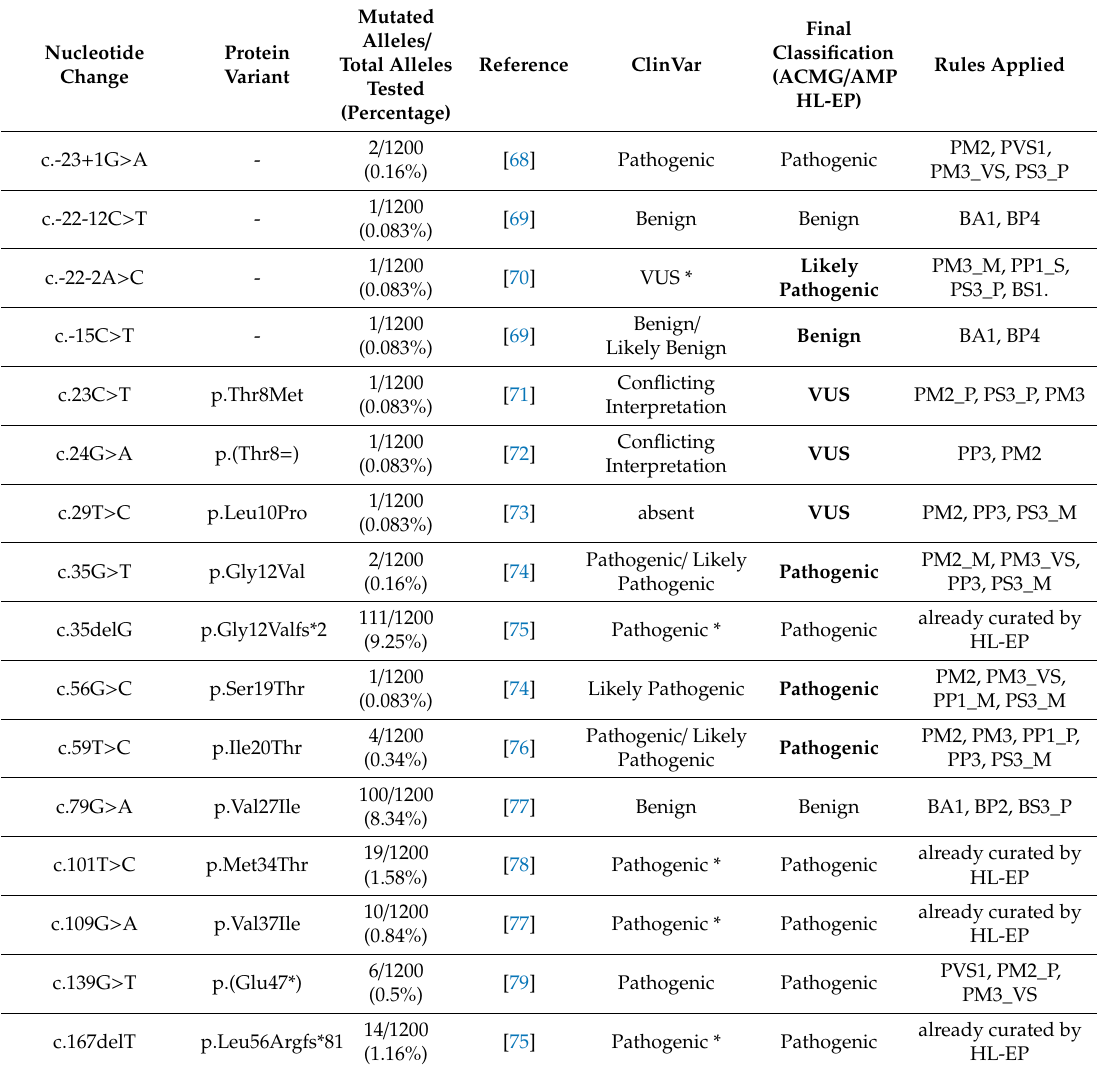
Table 1. Curated Variants. A total of 48 sequence variants were identified in GJB 2 and GJB 6 and 44